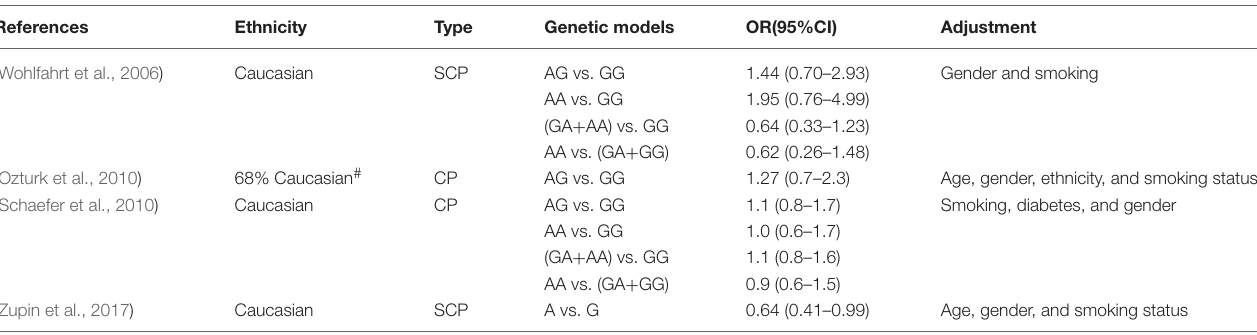
TABLE 2 | Adjustment and adjusted data of included studies.